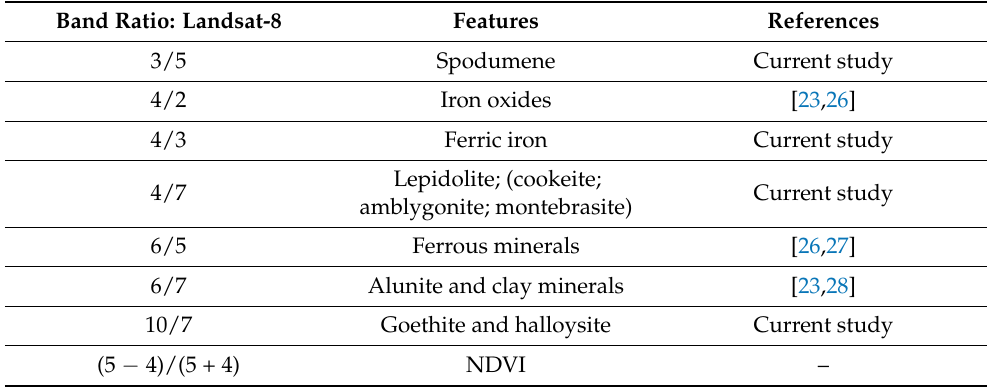
Table 2. Band-ratios applied for LANDSAT-8 imagery dated 25 February 2021. Band Ratio: Landsat-8 Features References 3/5 Spodumene Current study 4/2 Iron oxides [23,26] 4/3 Ferric iron Current study Lepidolite; (cookeite; 4/7 Current study amblygonite; montebrasite) 6/5 Ferrous minerals [26,27] 6/7 Alunite and clay minerals [23,28] 10/7 Goethite and halloysite Current